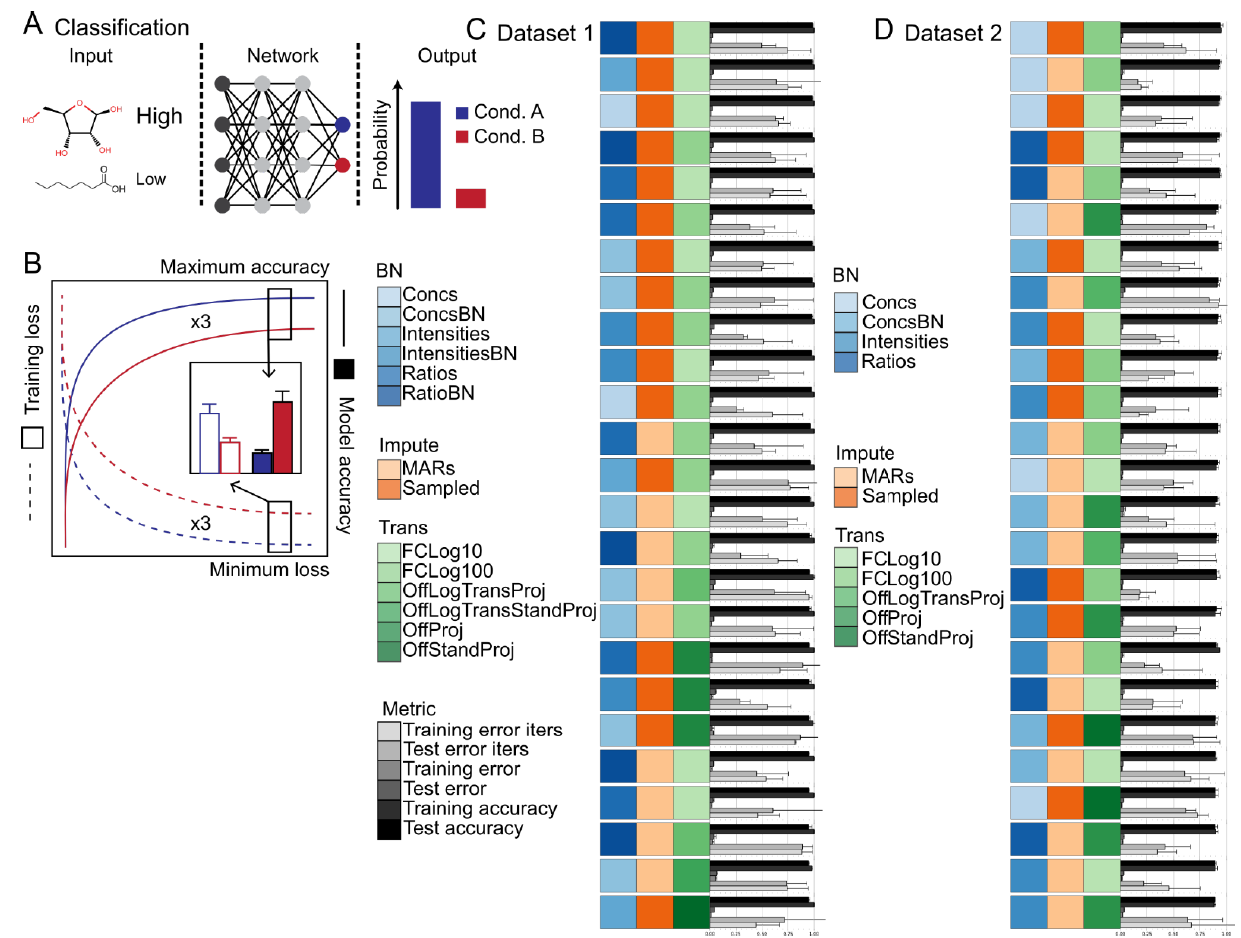
Figure 3. Summary of the classification task and evaluation procedure. ( A ) Schematic of the machine-learning classification task using metabolite levels as input and sample labels as output. ( B ) Diagram of the evaluation procedure. Training and test losses are depicted in blue and red. Summary of classification results for Dataset 1 ( C ) and Dataset 2 ( D ). The bars represent the model training iterations to minimum loss function scores, the model minimum loss function scores, and the model maximum accuracy ( n = 3 training runs). Error bars represent the standard deviation ( n = 3 training runs). Model training iterations to minimum loss and model loss scores are scaled from 0 to 1. The data are sorted in descending order based on model accuracy. The top 25 models are shown. Source data are provided in Tables S1 – S3 Abbreviations: BN — Biomass normalization; Impute — Imputation method; Trans — Transformation method.